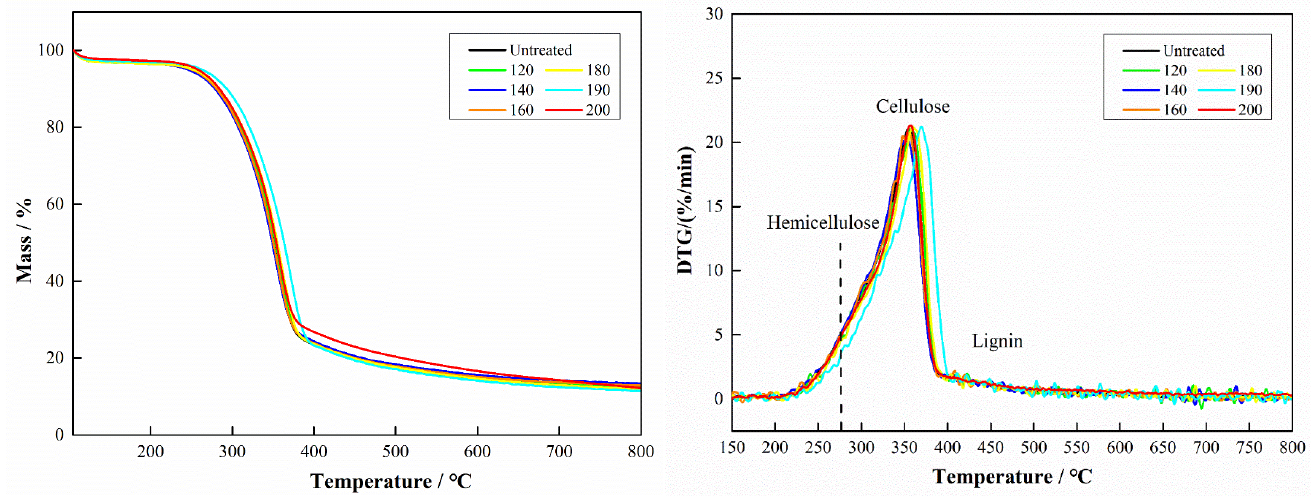
Figure 10. TG curves ( left ) and DTG ( right ) of fir in the heat treatment temperature 120–200 °C range.